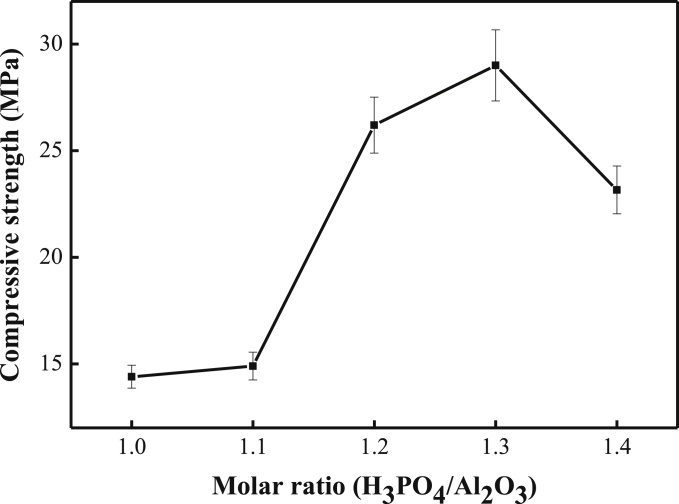
Compressive strength of the geopolymers with different H3PO4/Al2O3 molar ratios.